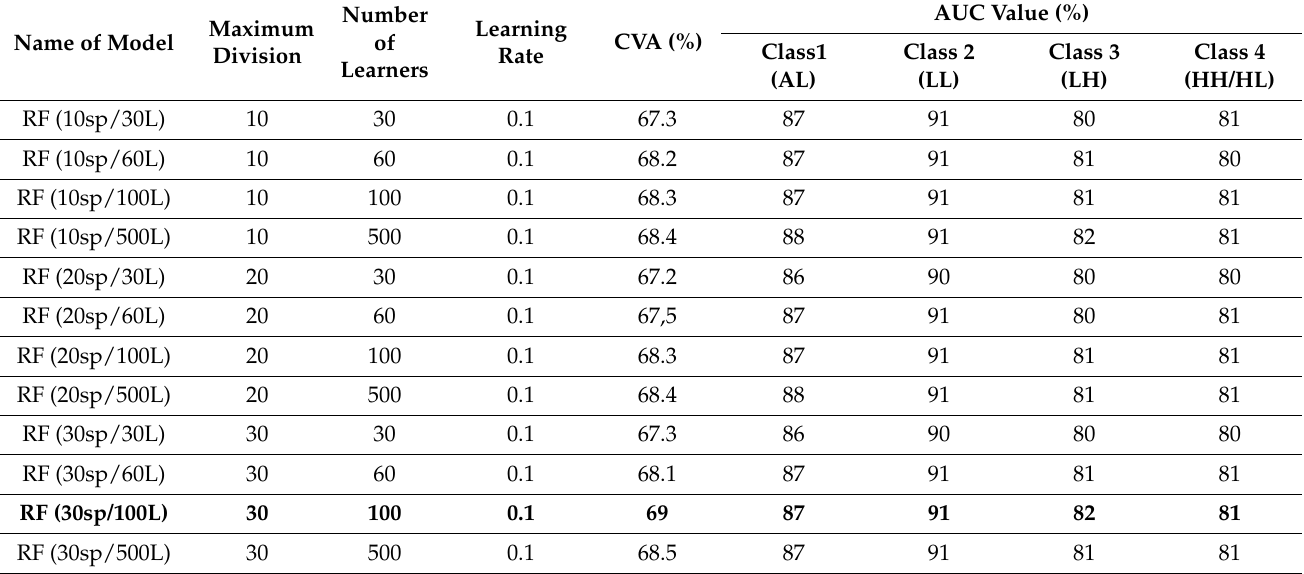
Table 7. Results of automatic classifications with RF. The best performing model that was selected for the RF category is shown in bold type.